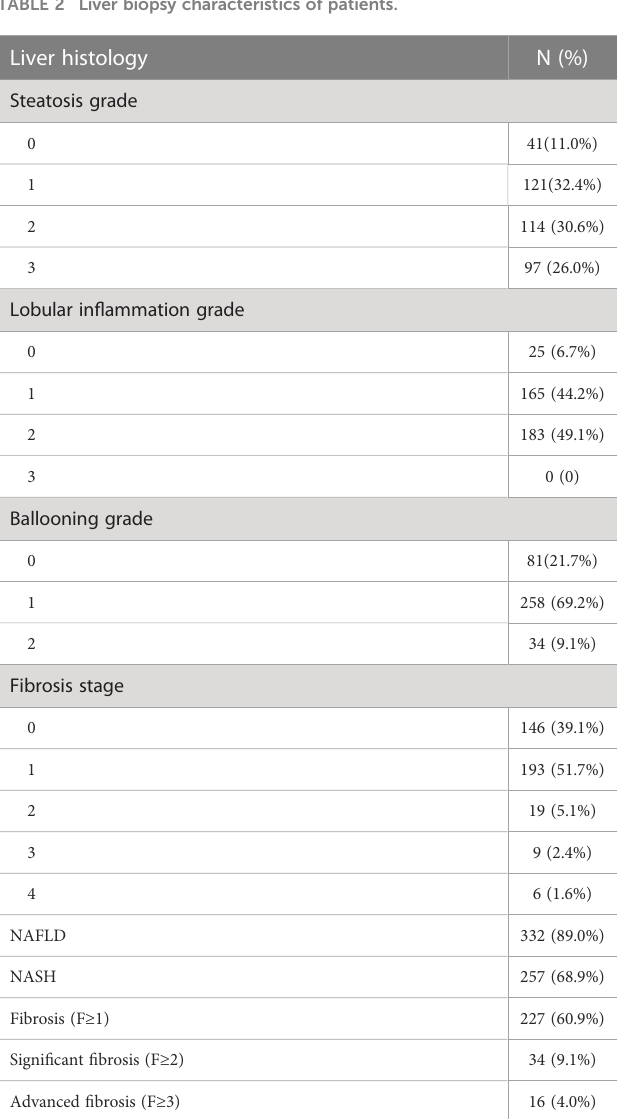
TABLE 2 Liver biopsy characteristics of